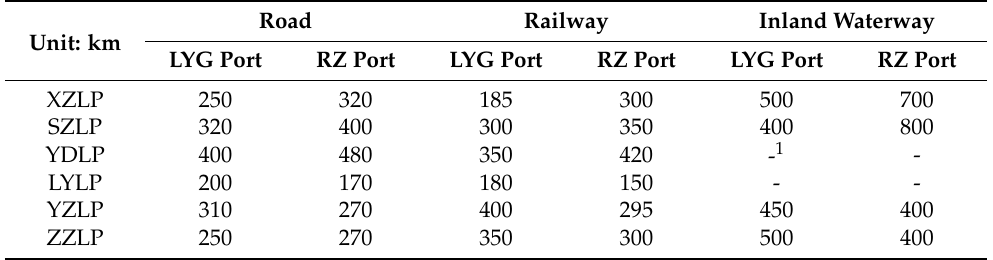
Table A2. Transport distance from domestic logistics park to domestic seaports by different modes. Road Unit: km